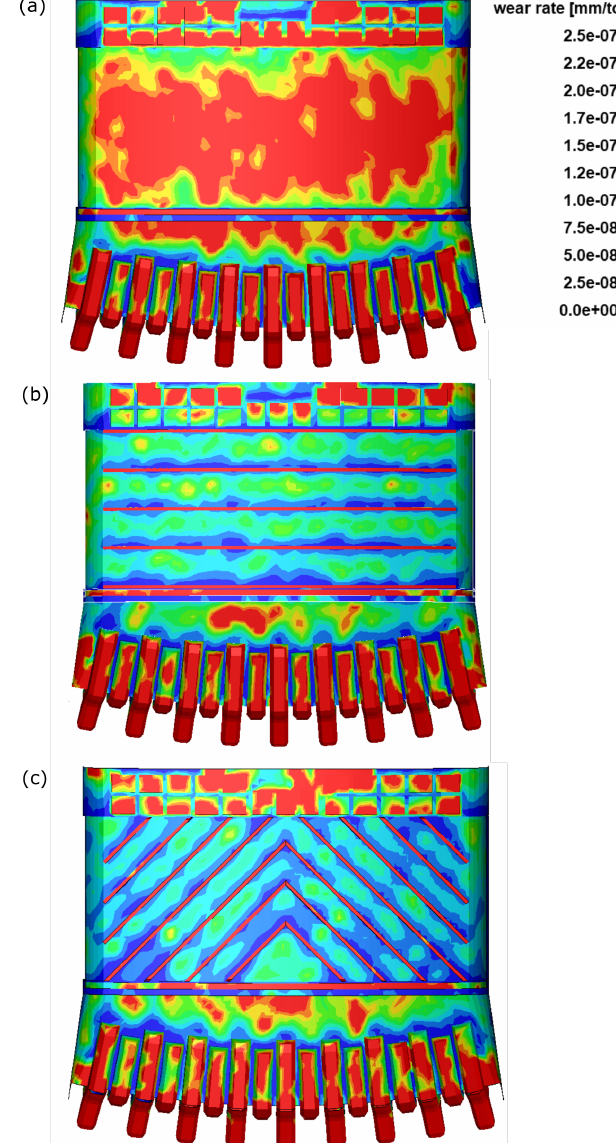
Figure 20. Wear on the bottom and the lip of the bucket shown for the baseline case ( a ), the changed geometry with wear bars located at 90 ◦ , ( b ) and wear bars located at 45 ◦ ( c ). The changed geometries of the buckets are presented in Figure 10. The view is from the top, similar to the view in Figure 18. The units of the wear rate is mm/ton and the color plots are the same for all